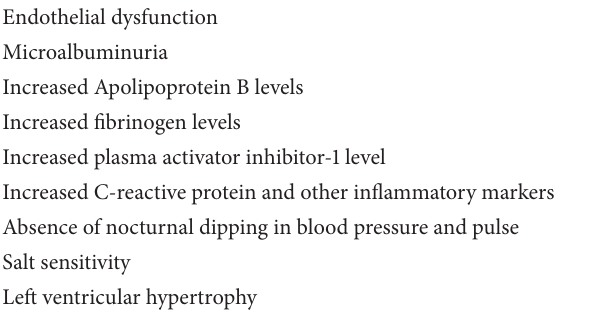
Table 2: Nontraditional risk factors for cardiovascular